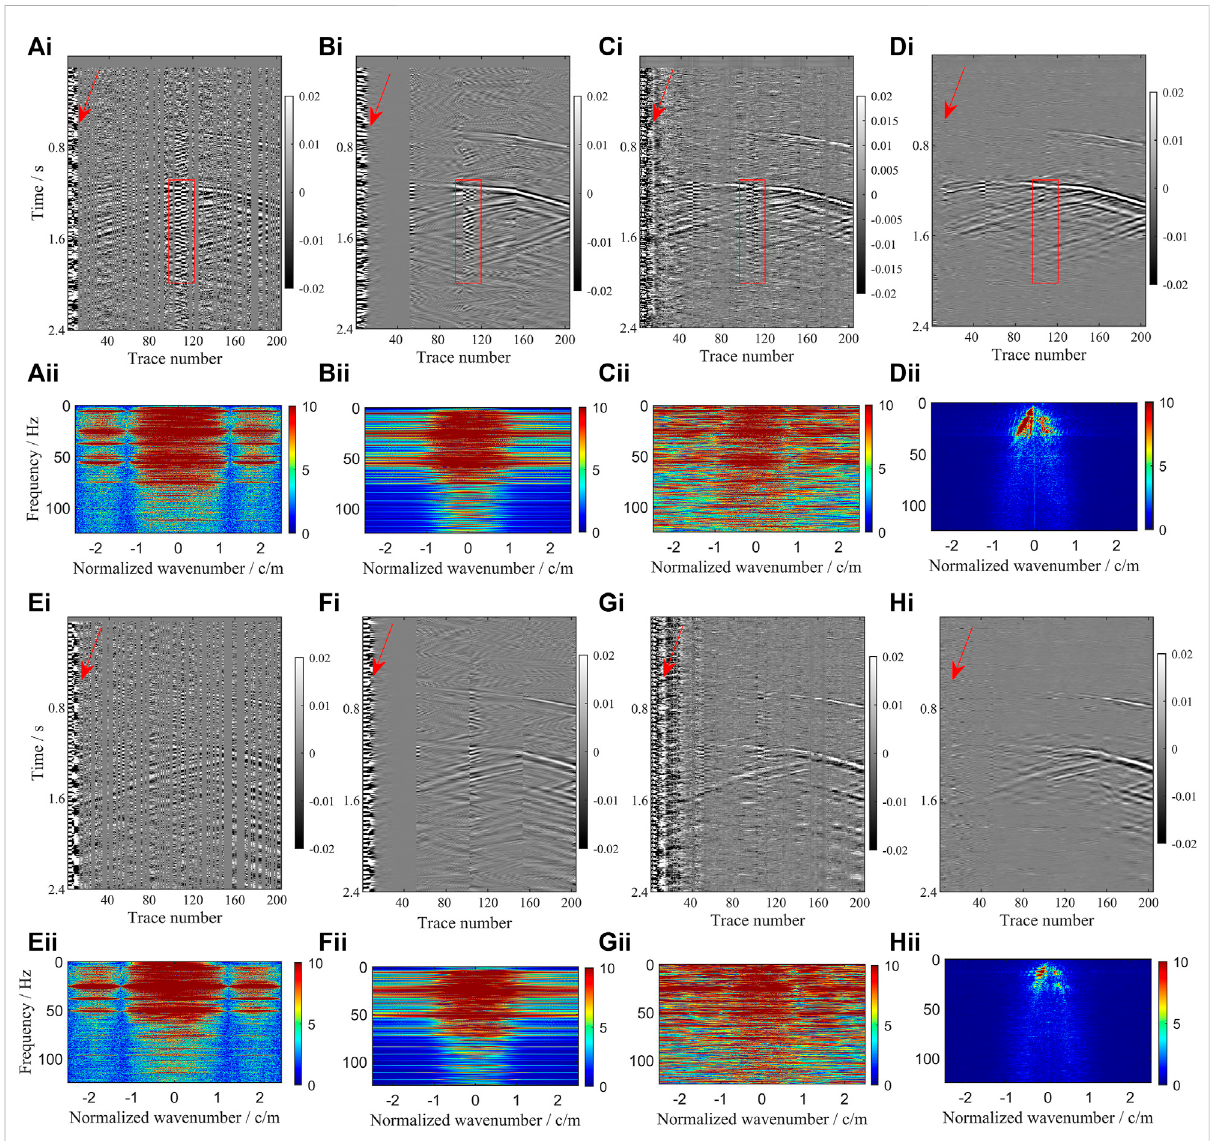
FIGURE 9 Simultaneous reconstruction and denoising results of the three methods in fi eld DAS-VSP data. (Ai) Original fi eld DAS-VSP data, shot1. (Bi) Result of (Ai) by rank reduction. (Ci) Result of (Ai) by U-net. (Di) Result of (Ai) by RRU-net. (Aii – Dii) FK spectrum of (Ai – Di) , respectively. (Ei) Original fi eld DAS-VSP data, shot1. (Fi) Result of (Ei) by rank reduction. (Gi) Result of (Ei) by U-net. (Hi) Result of (Ei) by RRU-net. (Eii – Hii) FK spectrum of (Ei – Hi) ,